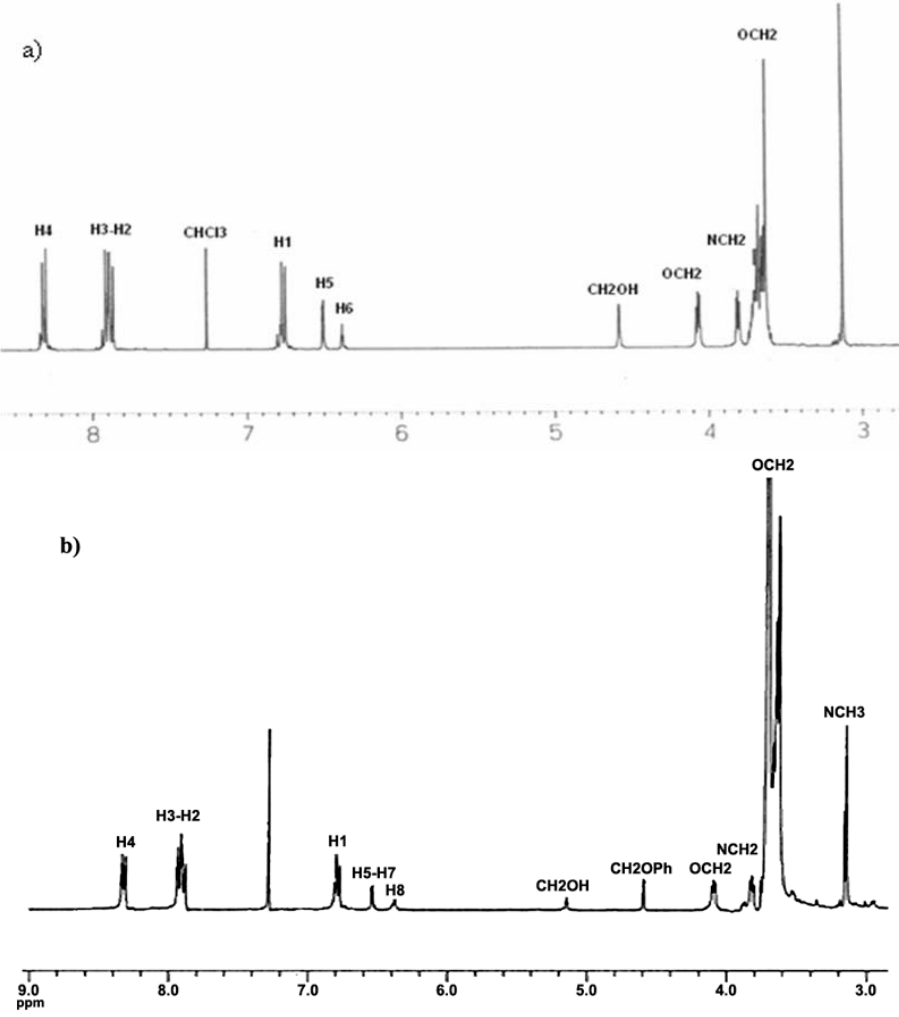
OH and ( b ) Second generation 1